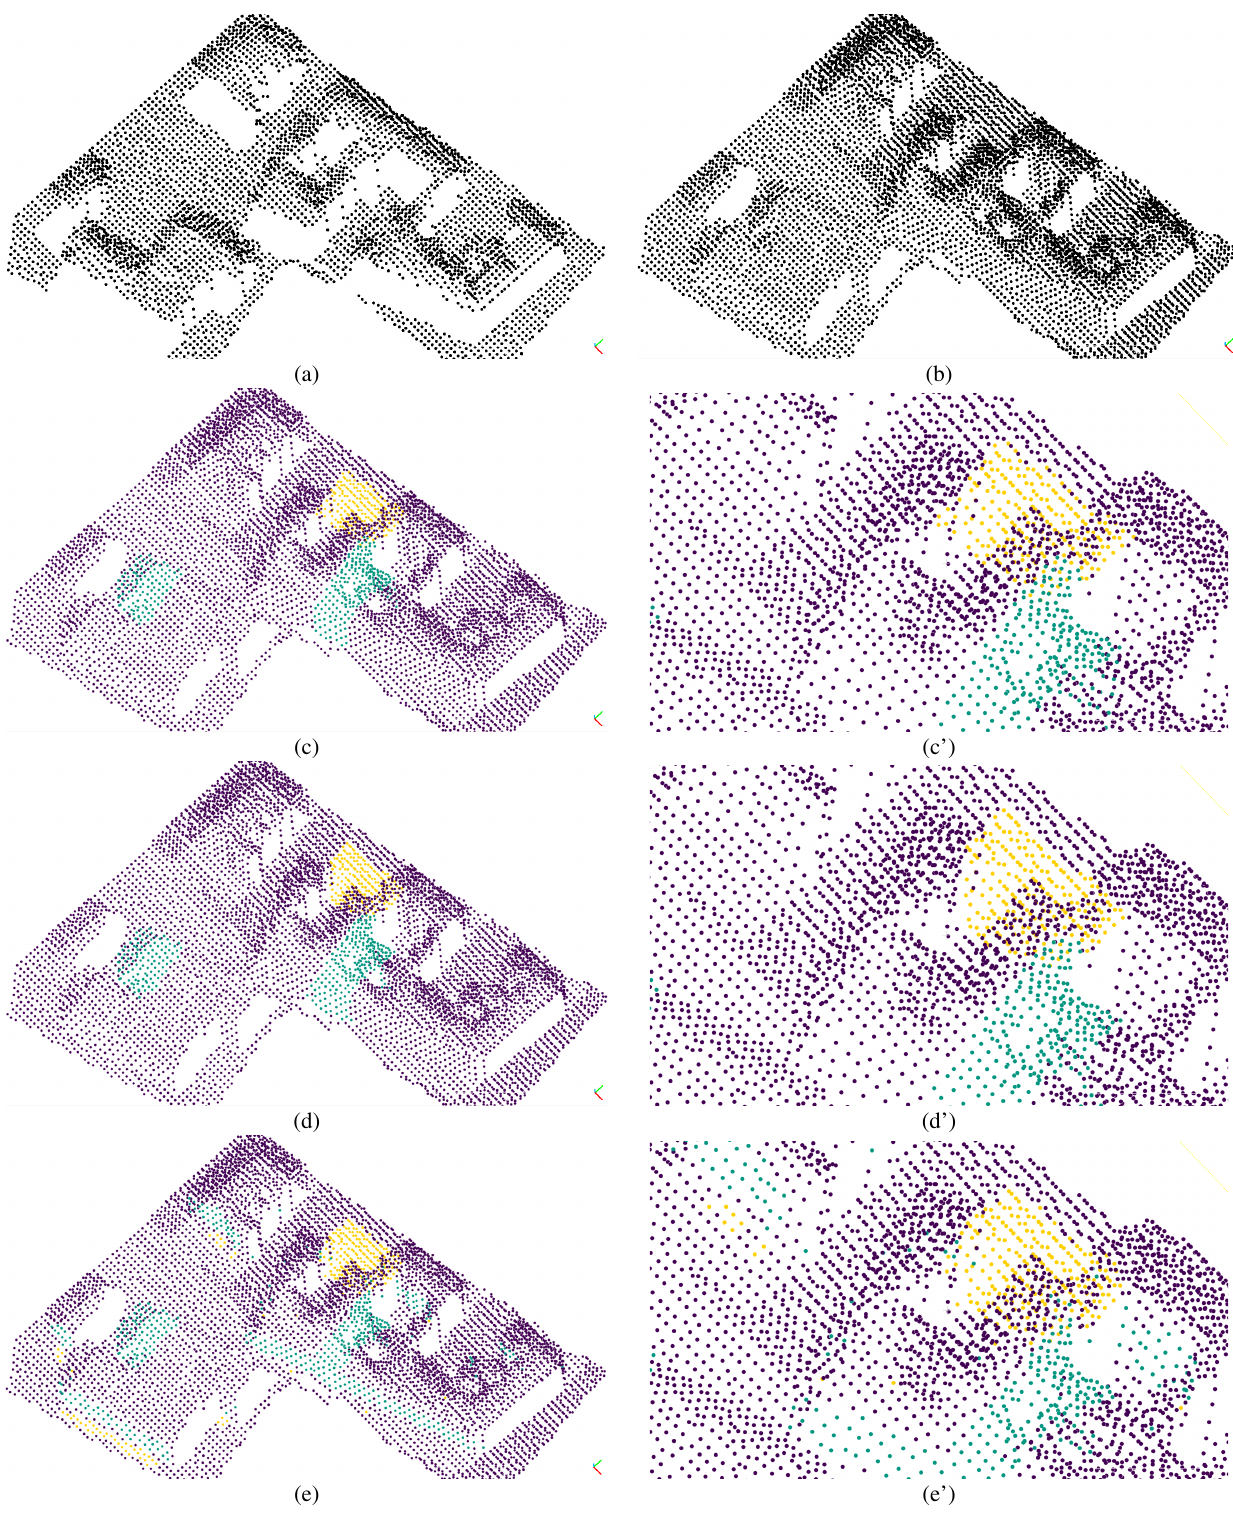
Figure 5. Visual change detection results. (a-b) the two input point clouds ; (c) simulated changes (purple: no change, blue: new construction, yellow: destruction) ; (d) our results; (e) results with (Tran et al., 2018) method; (’) denote close-up